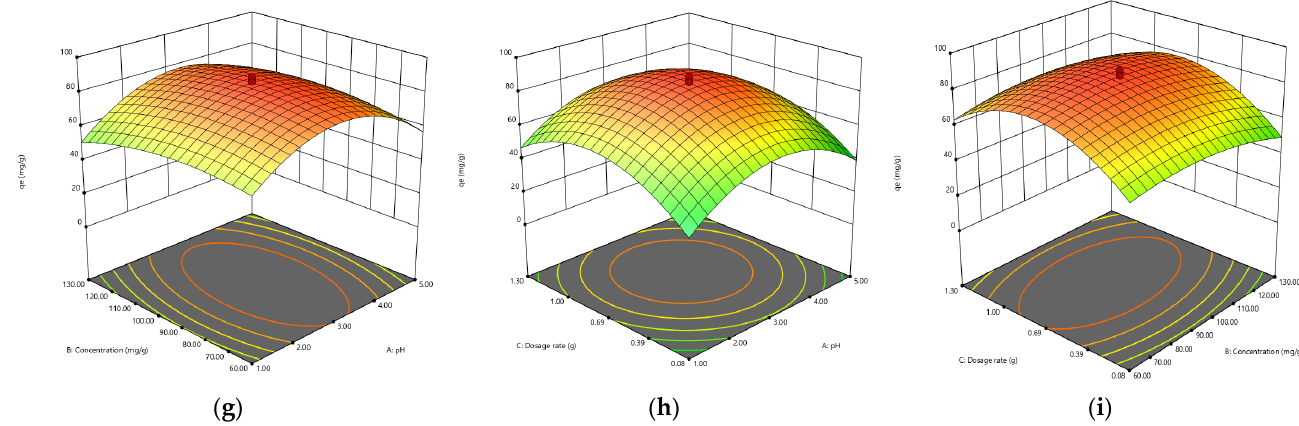
Figure 11. The 3D plots showing the interaction of ( a ) pH × concentration, ( b ) pH × adsorbent dosage, ( c ) concentration × adsorbent dosage by biomass; ( d ) pH × concentration, ( e ) pH × adsorbent dosage, ( f ) concentration × adsorbent dosage by biochar; ( g ) pH × concentration, ( h ) pH × adsorbent dosage, ( i ) concentration × adsorbent dosage by TiO 2 NC for adsorbtion of Cr(VI).